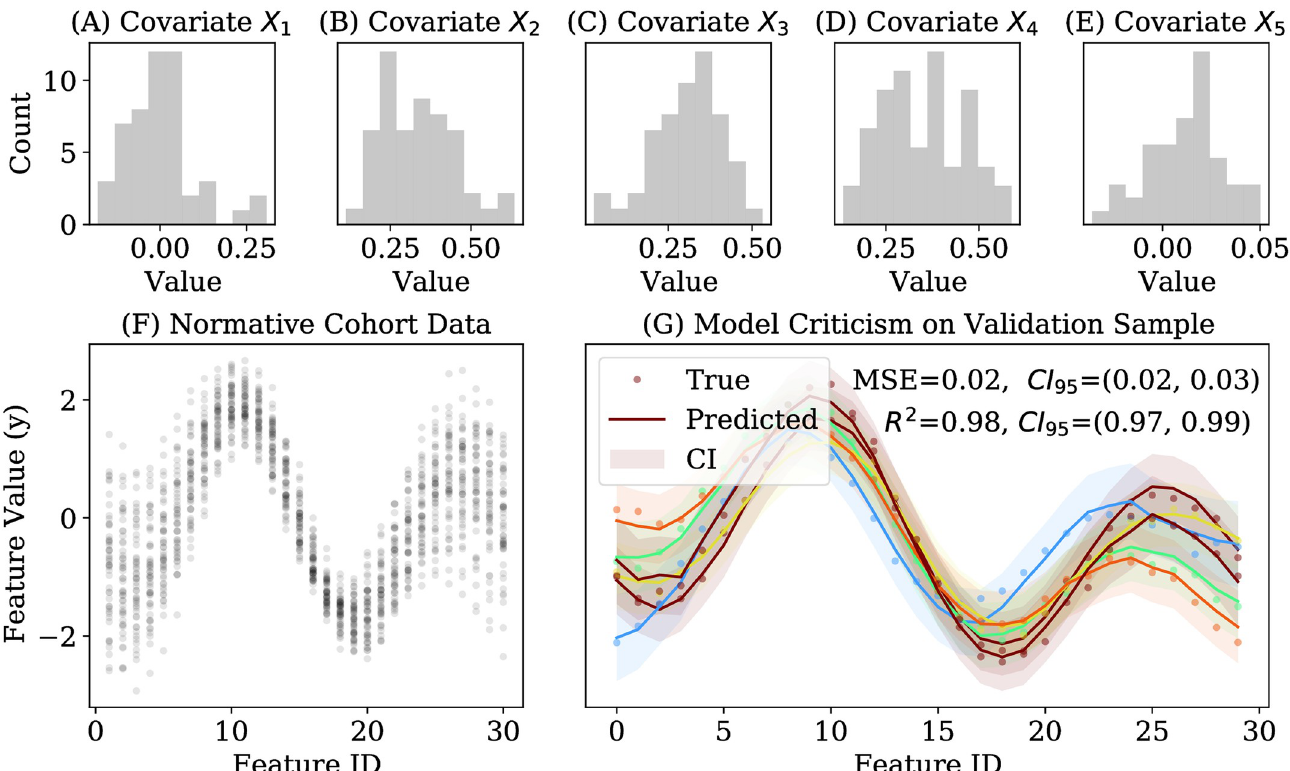
Fig 1. Illustration of simulated data and normative model. Panels A-E : Simulated distribution of five covariates. Panel F : Example of simulated data for M = 30 features and N = 50 subjects in a normative cohort. Panel G : Criticism of a normative model fit to the data in Panel A for 6 new subjects from the normative distribution (different color per